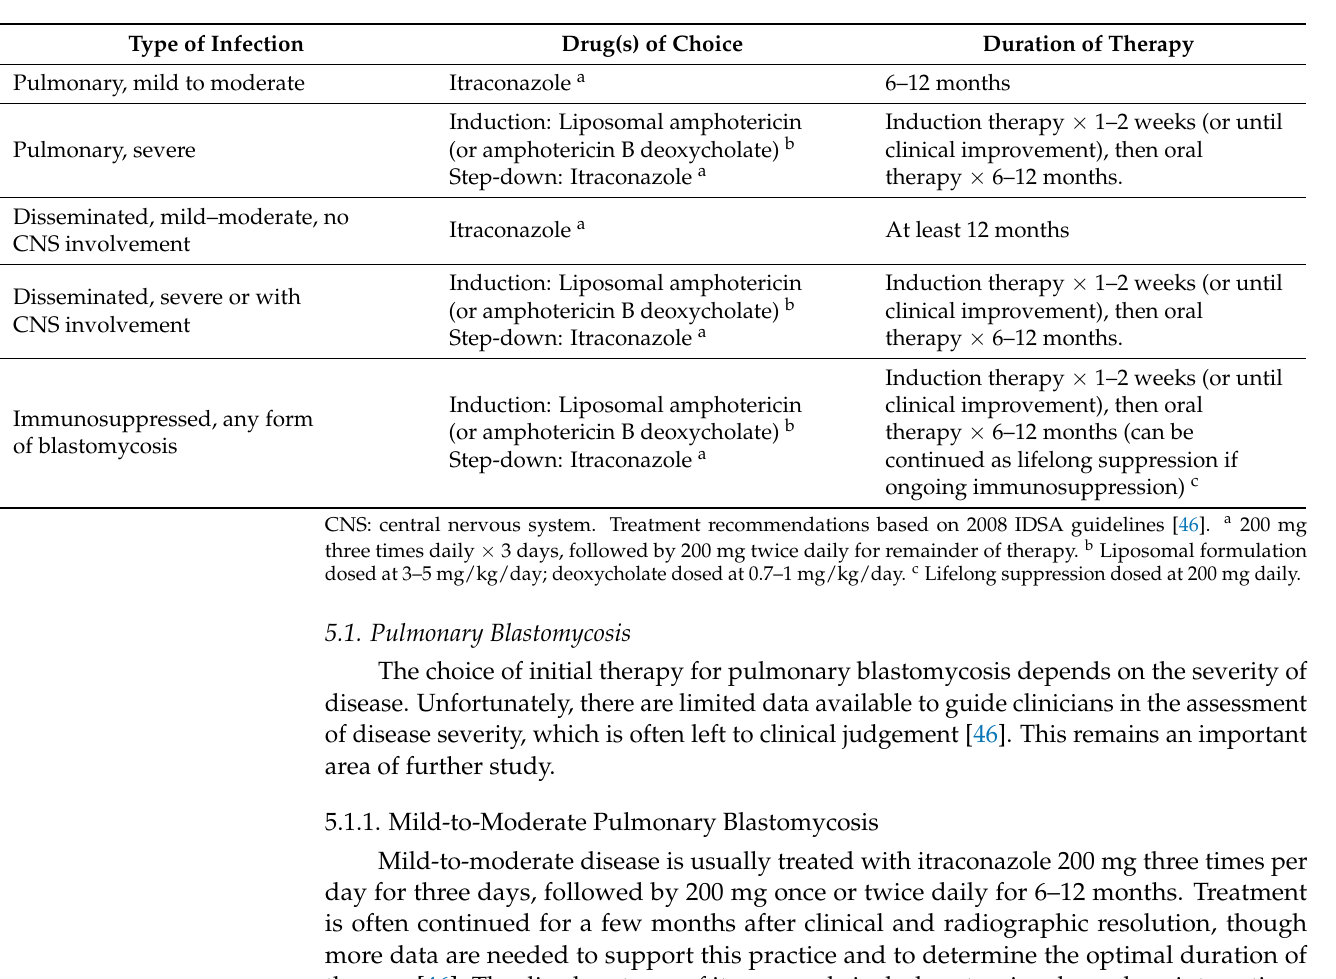
Table 1. Management of